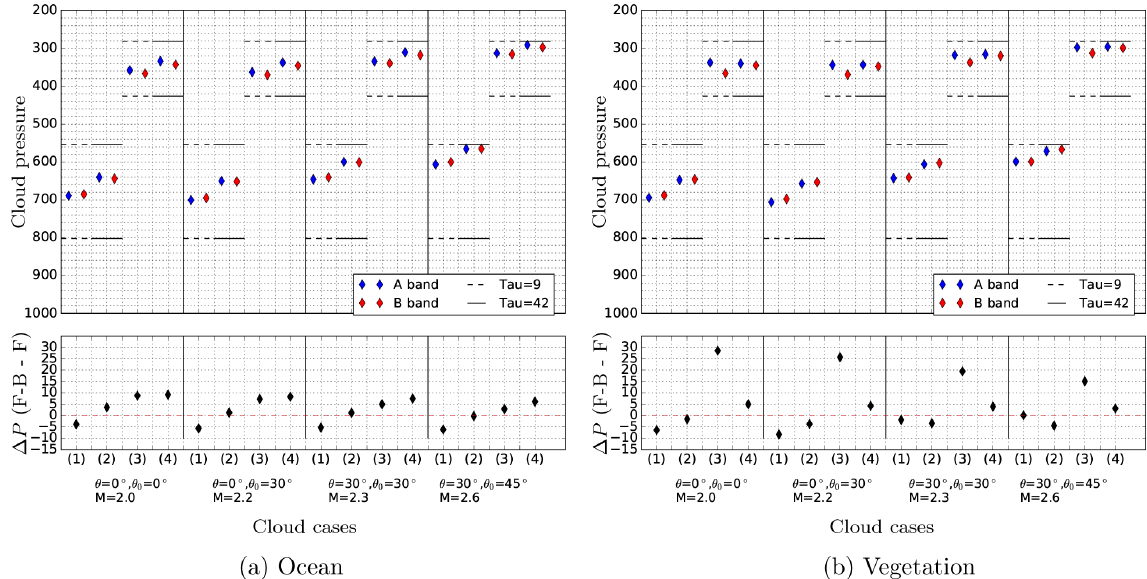
Figure 6. FRESCO-B (F-B) and FRESCO (F) cloud pressure retrievals (top panels) and cloud pressure differences (bottom panels) for the simulated cloud scenes over ocean (a) and vegetation (b) . The cloud cases are described in Table 1. The simulations have been made with an azimuth angle difference of 90 ◦